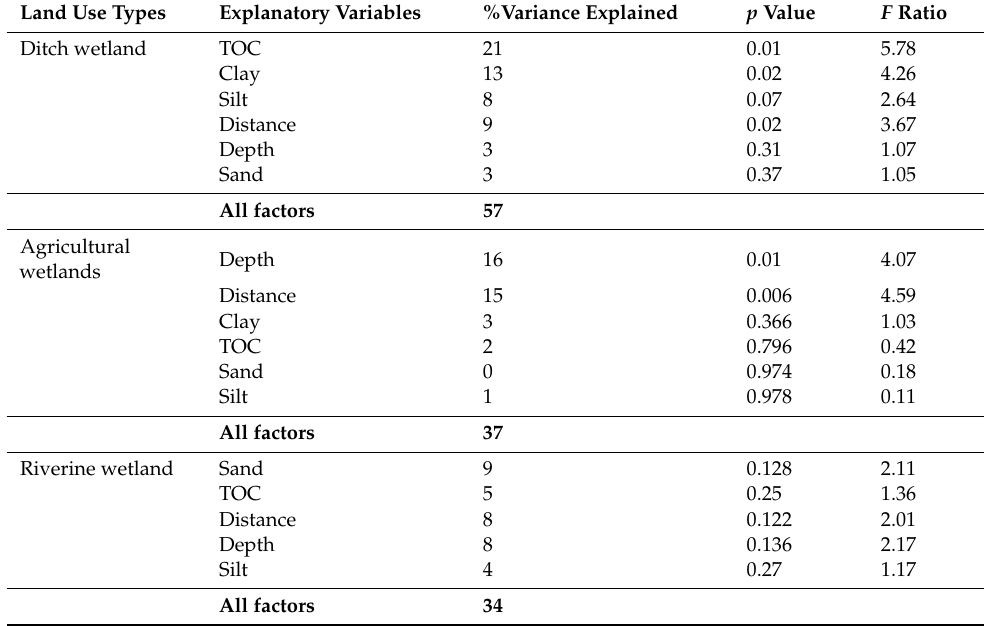
Figure 5. Biplot map of hybrid redundancy analysis (RDA) for PAHs and soil properties. The blue arrows represent PAHs and the red arrows represent the influencing factors. The length of the arrow represents the degree of influence for each environmental factor on the PAHs composition in ditch wetlands ( A ), agricultural lands ( B ), and riverine wetlands ( C ). Table 5. RDA results showing the percentage variance explained for PAHs in three land use types. Land Use